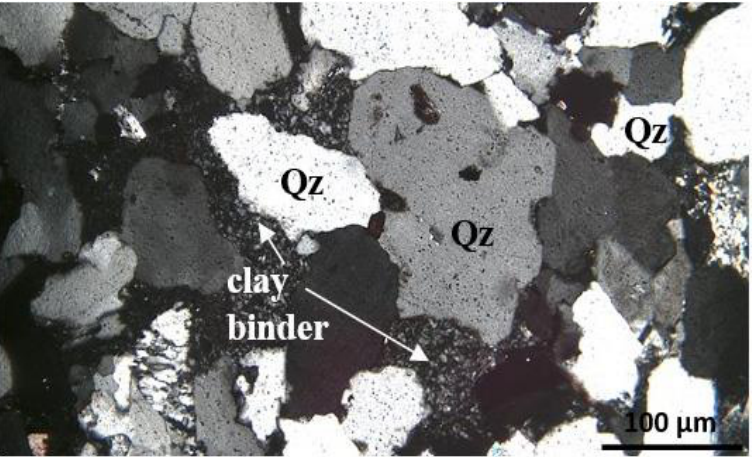
Figure 7. Wavy quenching of light on quartz grains (Qz), surrounded by clay binder: crossed polars—100× magnification.